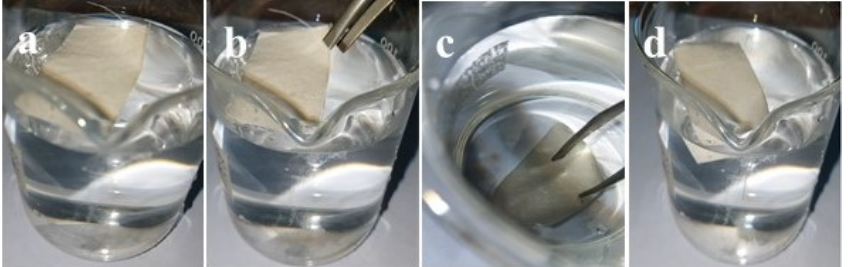
Figure 11. Water floating test of coated fabric with modified nano titania. ( a ) Coated fabric floating on the water surface. ( b ) Forcing down the fabric into water. ( c ) Coated fabric forced to the bottom of water filled beaker. ( d ) Fabric back on the water surface after removal of external force.